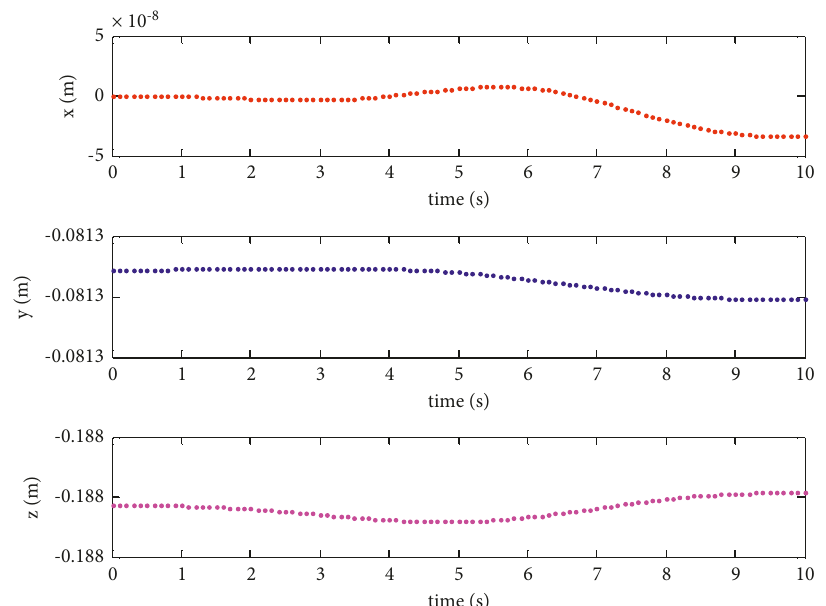
Figure 5: The position of the base obtained by the IQPSO